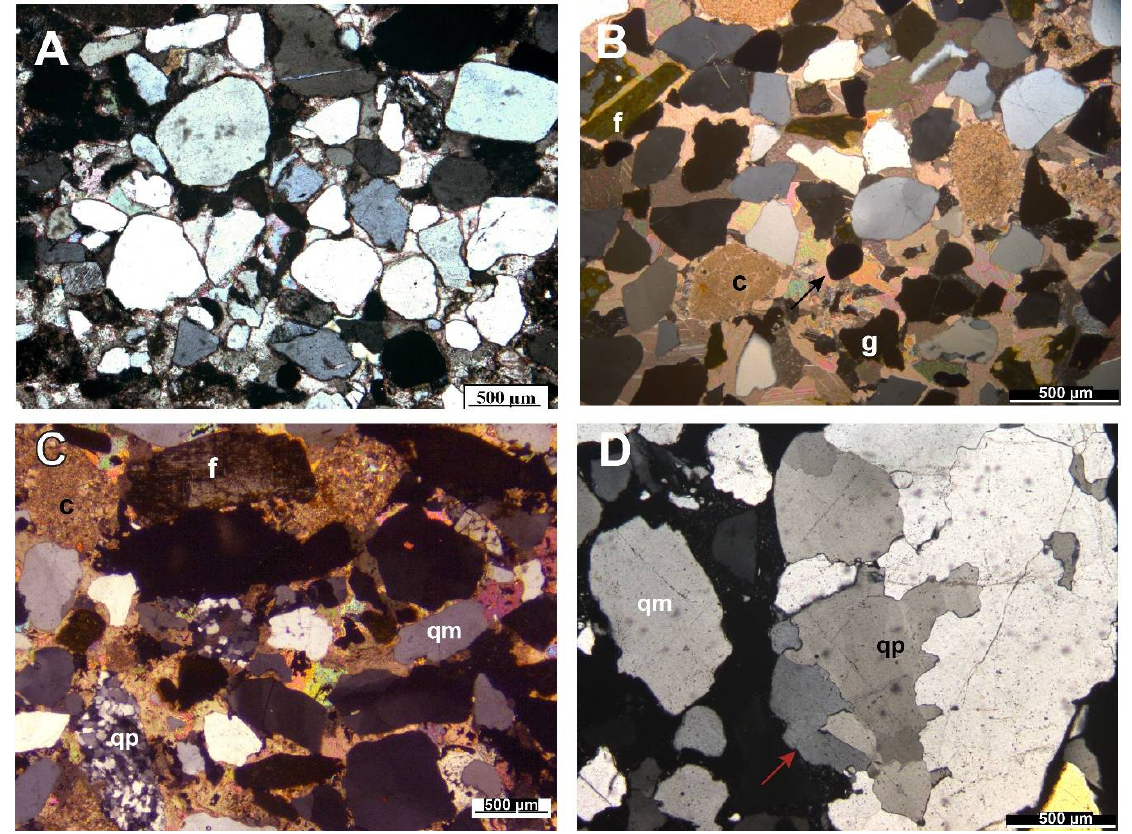
Figure 4. Photomicrographs showing ( A ) fine- to medium-sand-size, sub-rounded to sub-angular framework grains with dominantly tangential or point contact between them; ( B ) fine- to medium- sand-size framework grains of carbonate (c) and stained orthoclase feldspar (f) along with a few opaque heavy minerals (black arrow) and garnet (g), with poikilotopic calcite cement occupying the intergranular spaces within the Maleri sandstone sample. Photomicrographs showing ( C ) mostly quartz (monocrystalline-qm and polycrystalline-qp) and k-feldspar (f) grains along with carbonate grains (c) with tangential or point contact between the framework grains, in poikilotopic calcite cement; ( D ) medium- to coarse-sand-size, sub-angular polycrystalline quartz grain (red arrow), within the Dharmaram sandstone sample.